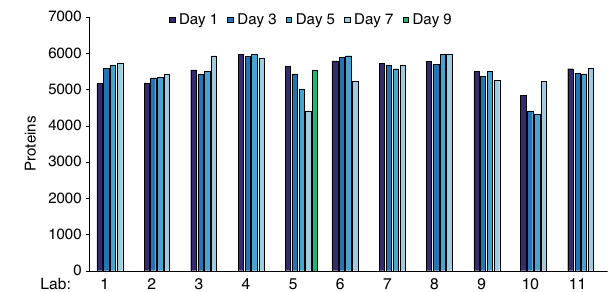
Fig. 2 Quality control performance. The number of proteins identi fi ed (with a 1% FDR) from the HRMS1-DIA analyses of QC sample (2 µ g of Hela digest on column) prior to analysis of the controlled samples at each laboratory was plotted over the 7-day evaluation period. Different days are indicated by shades of blue. The evaluation period was expanded to 9 days (green bar) for laboratory 5, which experienced technical issues on day 7 that were subsequently resolved. Source data are provided as a Source Data fi